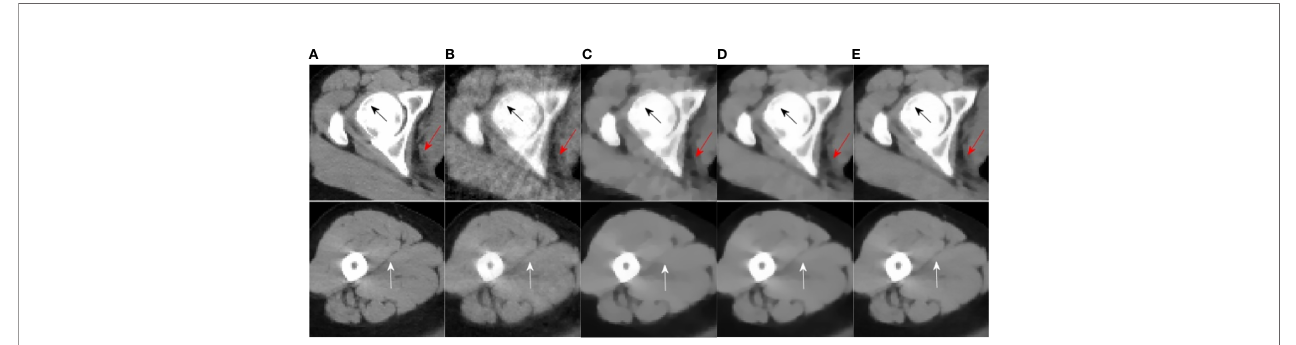
FIGURE 6 | ROI area enlarged image: the fi rst row and the second row are the enlarged images of the red box area in Figure 4 and Figure 5 , from left to right there are the reference image, SART, ASD-POCS, TpV and TpV- Reconstructed image of GIF. The (A – E) in this fi gure are correspond to the (A – E) in Figure 4